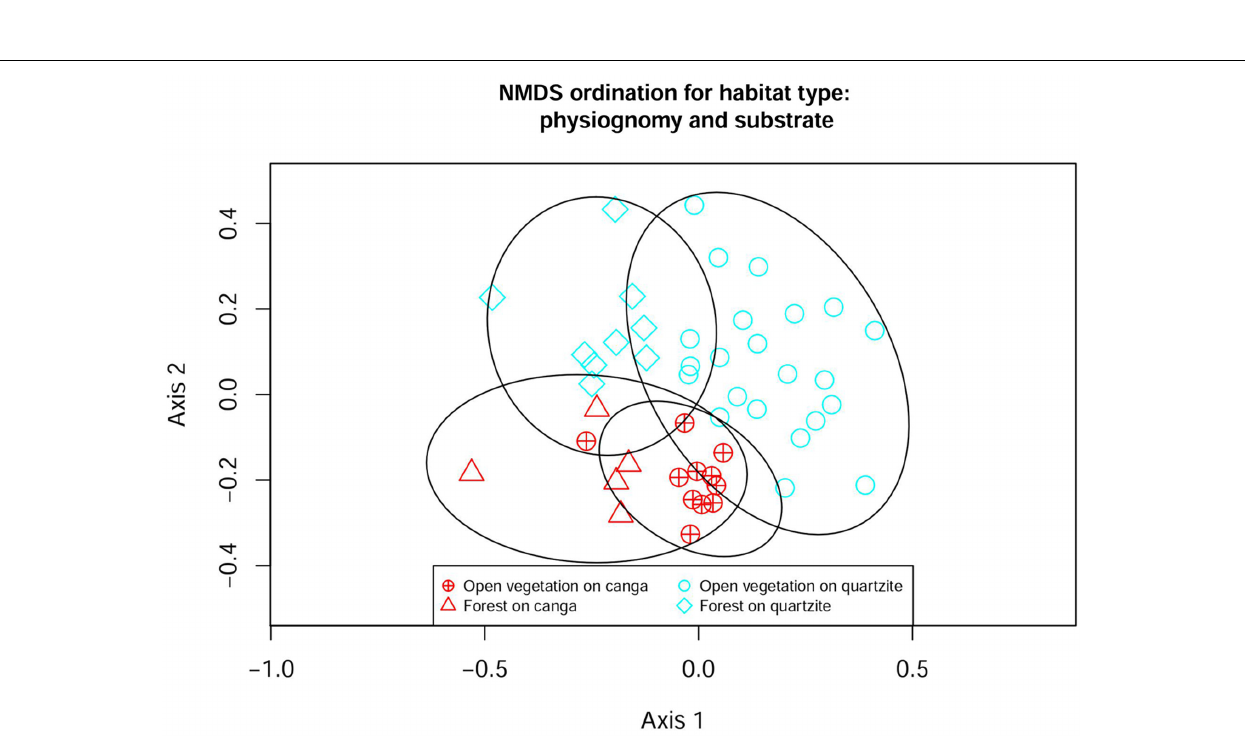
FIGURE 5 | Non-metric multidimensional scaling (NMDS) ordination of 47 sites in the Espinhaco range. Bray–Curtis distance, final stress = 0.23. Ellipses show 95% confidence limits for delimitation of each group.